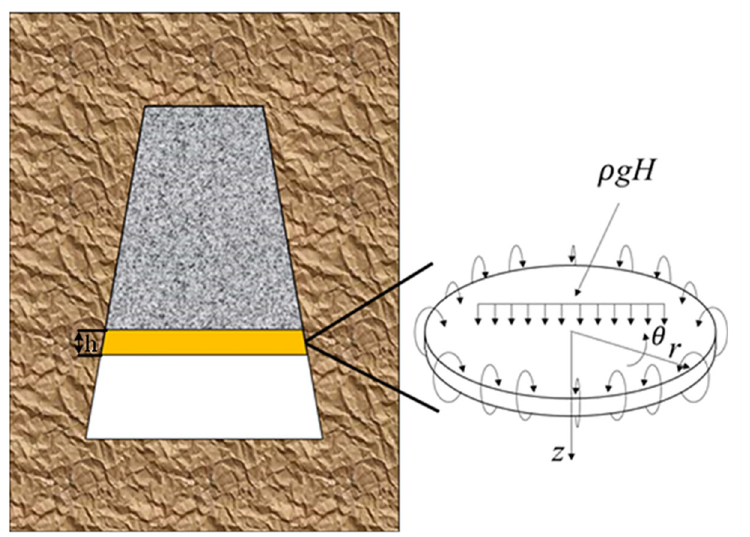
Fig 2. Failure mechanics model of karst cave